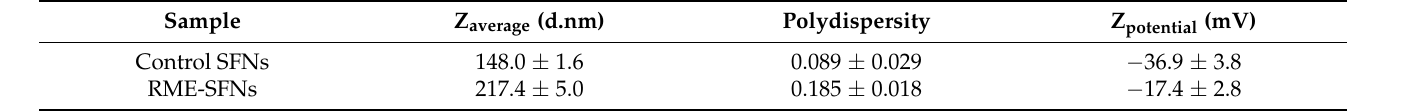
Table 3. Characterization of the silk fibroin nanoparticles by Dynamic Light Scattering.